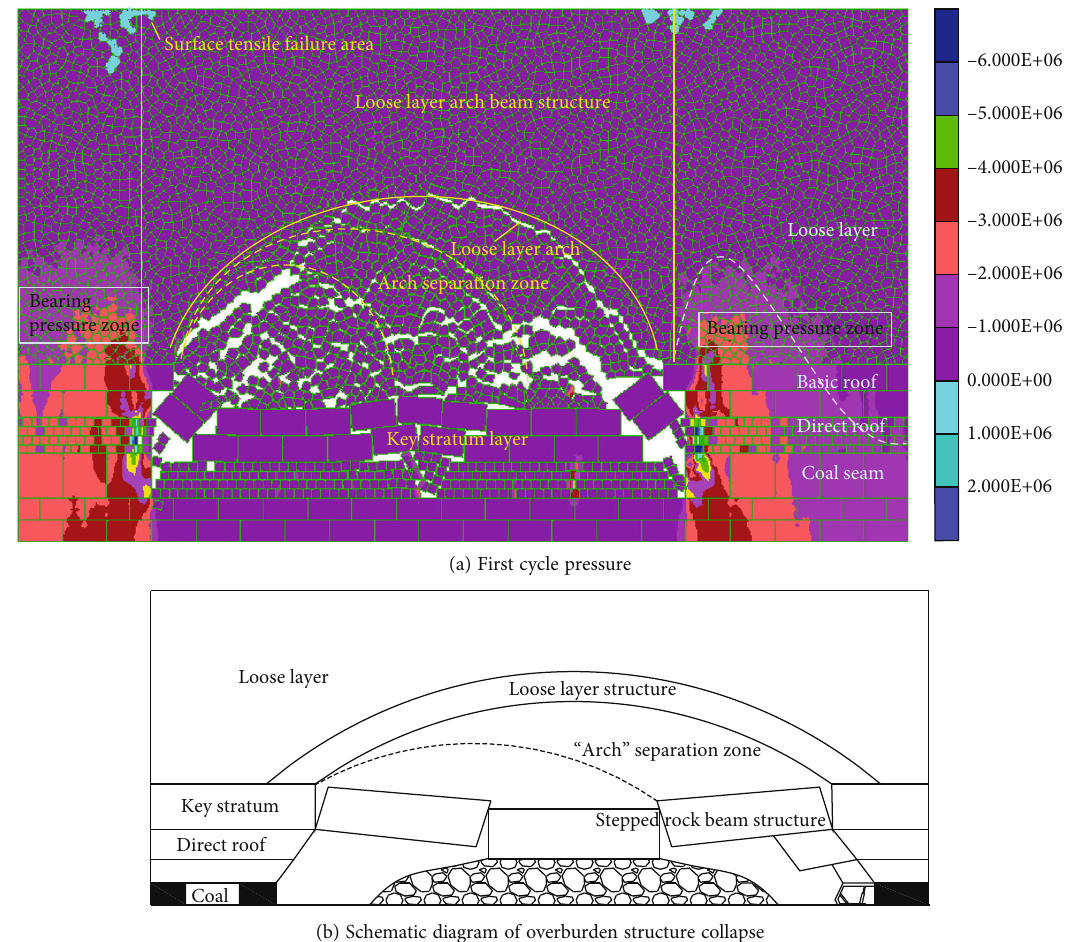
Figure 16: Schematic diagram of arch structure during periodic